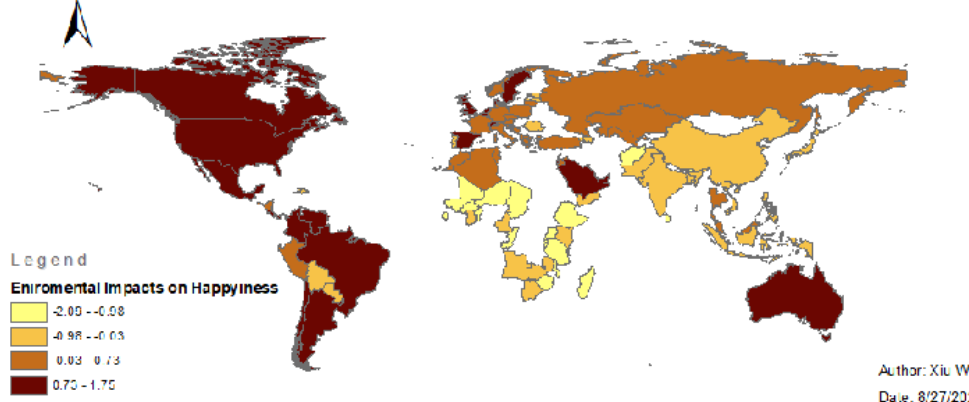
Figure 2. Cross-sectional fixed effects panel regression model map. Note: The above map was created by ArcMap software from Esri. Co.